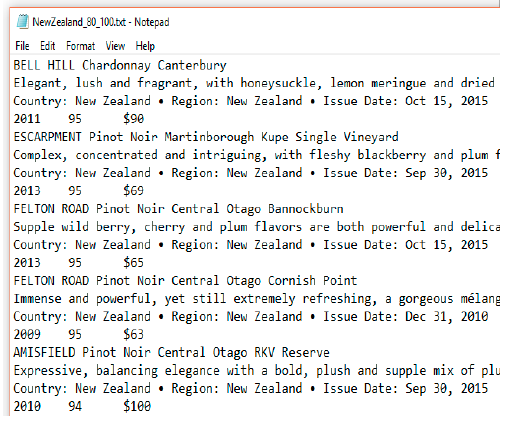
Figure 3. Wine Review Format.